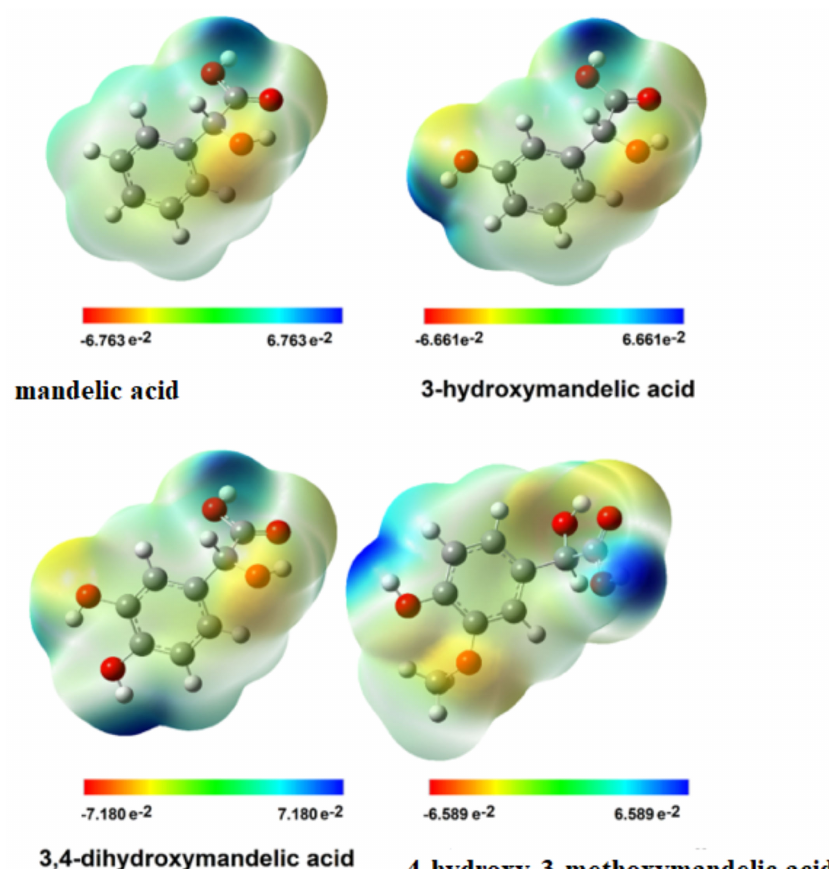
Figure 5. Maps of the electrostatic potential distribution of EPS in mandelic acid and its